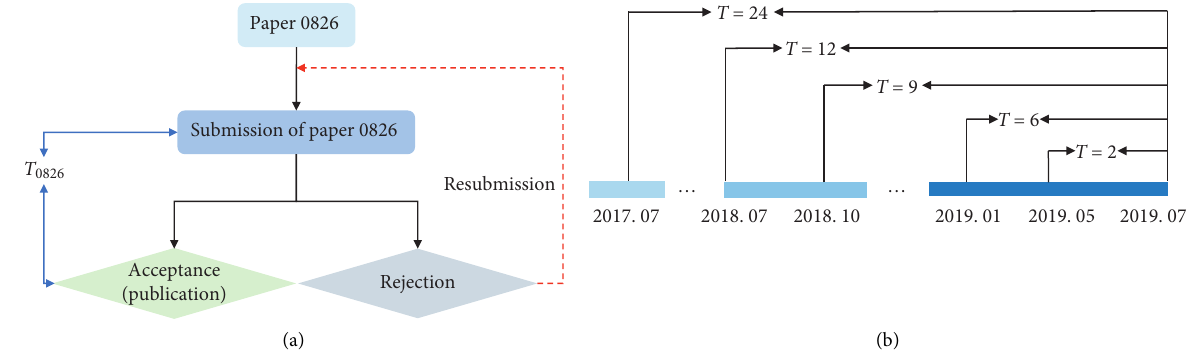
Figure 1: Sketch of the average review time of a type of journal ( T ).